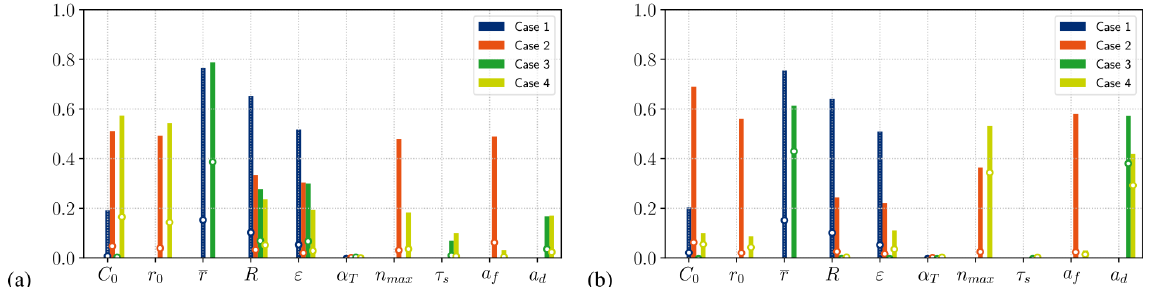
Figure 7. Aggregated first-order Sobol indices (dots) and aggregated total Sobol indices (bars) for temperature (a) and total frazil volume fraction (b) for cases 1, 2, 3 and